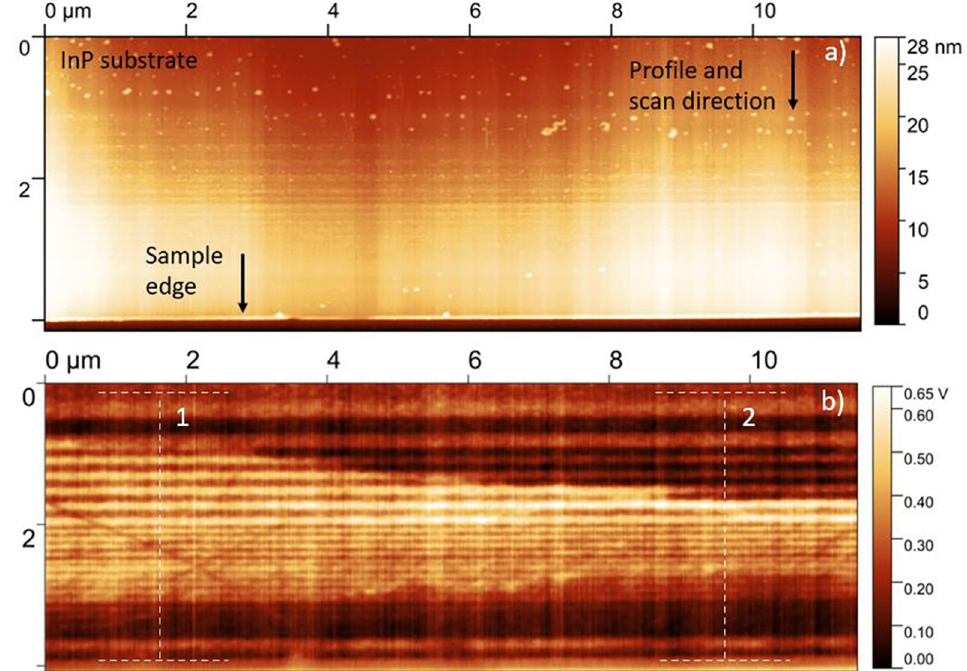
Fig. 3. KPFM measurement in ambient conditions on the surface cross-section of the InP sample in dark conditions. (a) Topography image of the cross-section of the InP sample after chemical removal of the oxide layer. (b) The V CPD image measured during the second pass. Two regions with different V CPD progression were detected and labelled with 1 and 2. The resolution of the images is set to 1024 (cid:3) 1024 pixels per point.